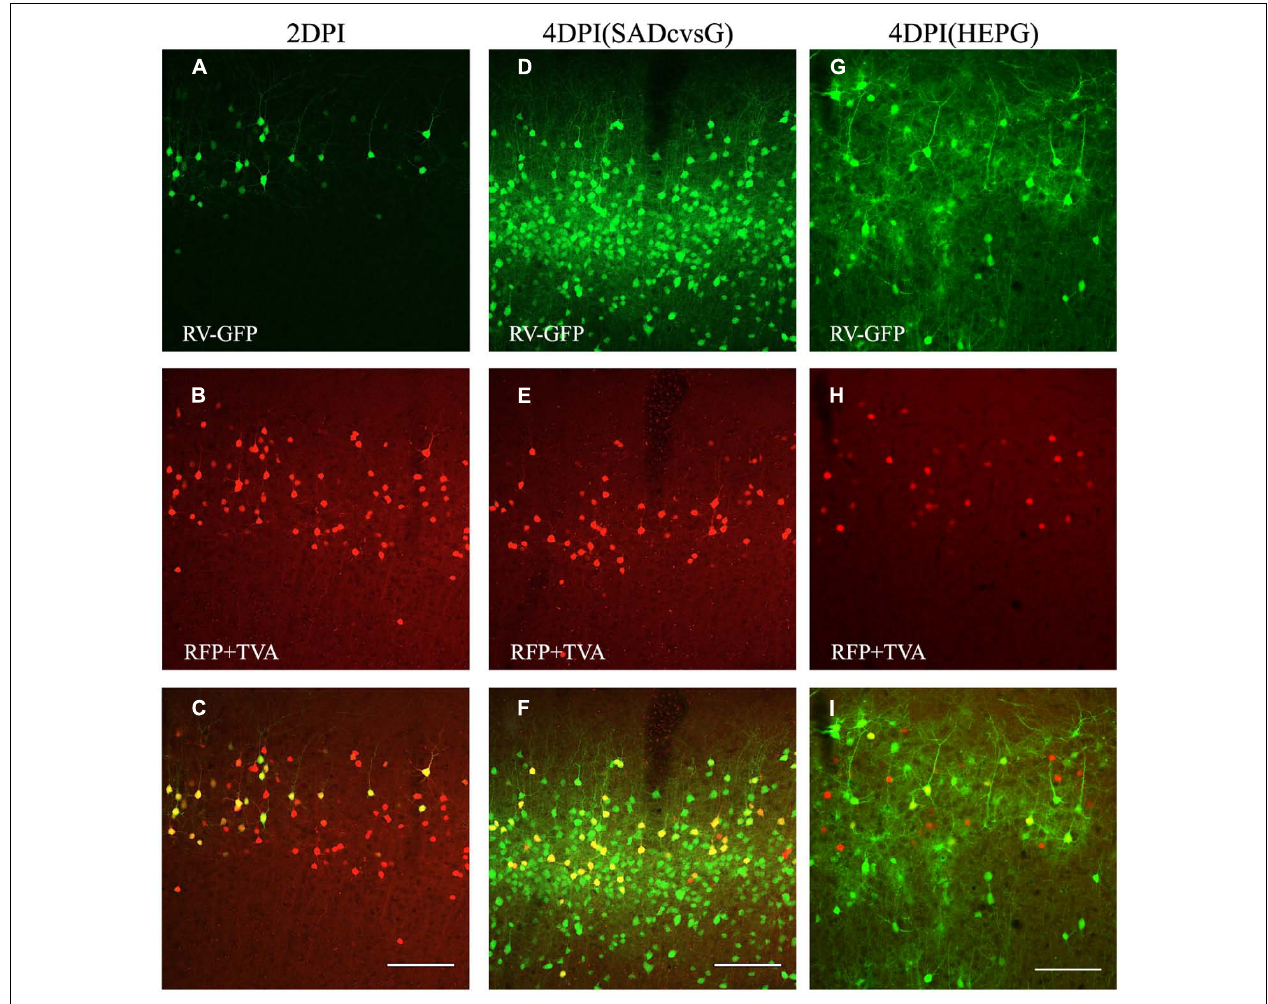
FIGURE 4 |Time course of monosynaptic spreading of HEP- Δ G-GFP. The resulting adult mice were perfused 2 (A–C) or 4 (D–I) days post infection (DPI) with EnvA- HEP- Δ G-GFP. Monosynaptic tracing with SADcvsG (D–F) or HEPG (G–I) occurred on 4 DPI. Top, RV-infected GFP